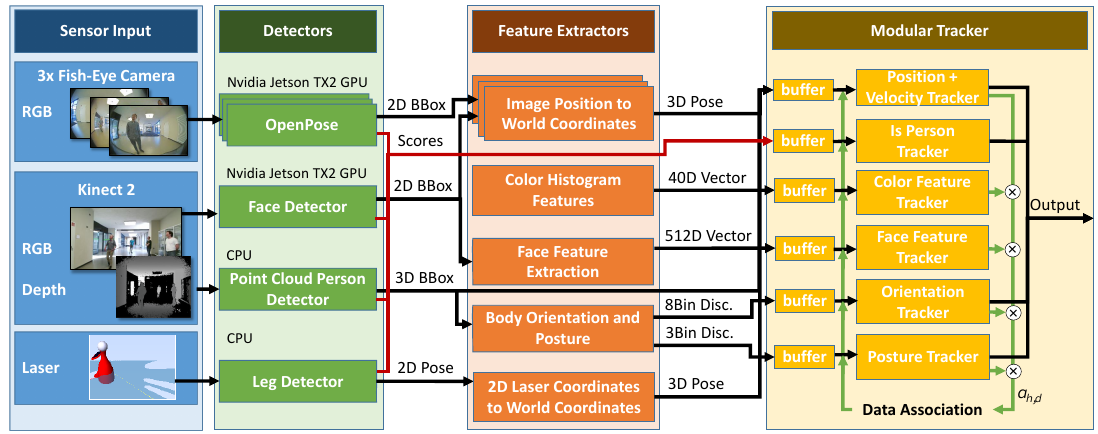
Figure 2. Overview of the modular person detection and tracking